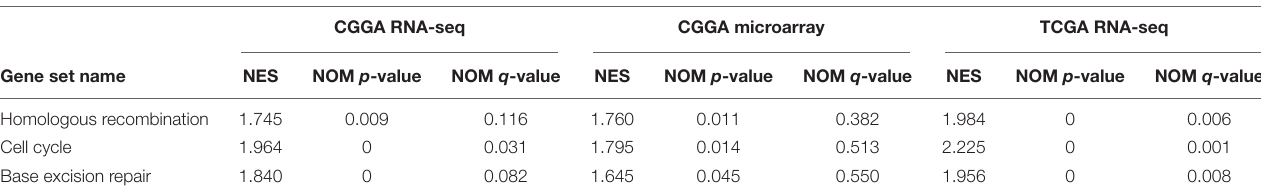
TABLE 2 | The gene set enriches the high ESPL1 expression